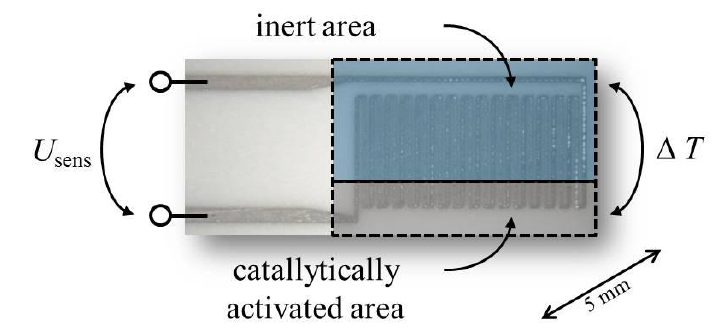
Figure 1. Part of the sensors front side: A screen-printed Pt/PtRh thermopile structure measures the temperature gradient between an inert and a catalytically activated area by a thermovoltage. Gas reactions on the catalyst affect the signal.